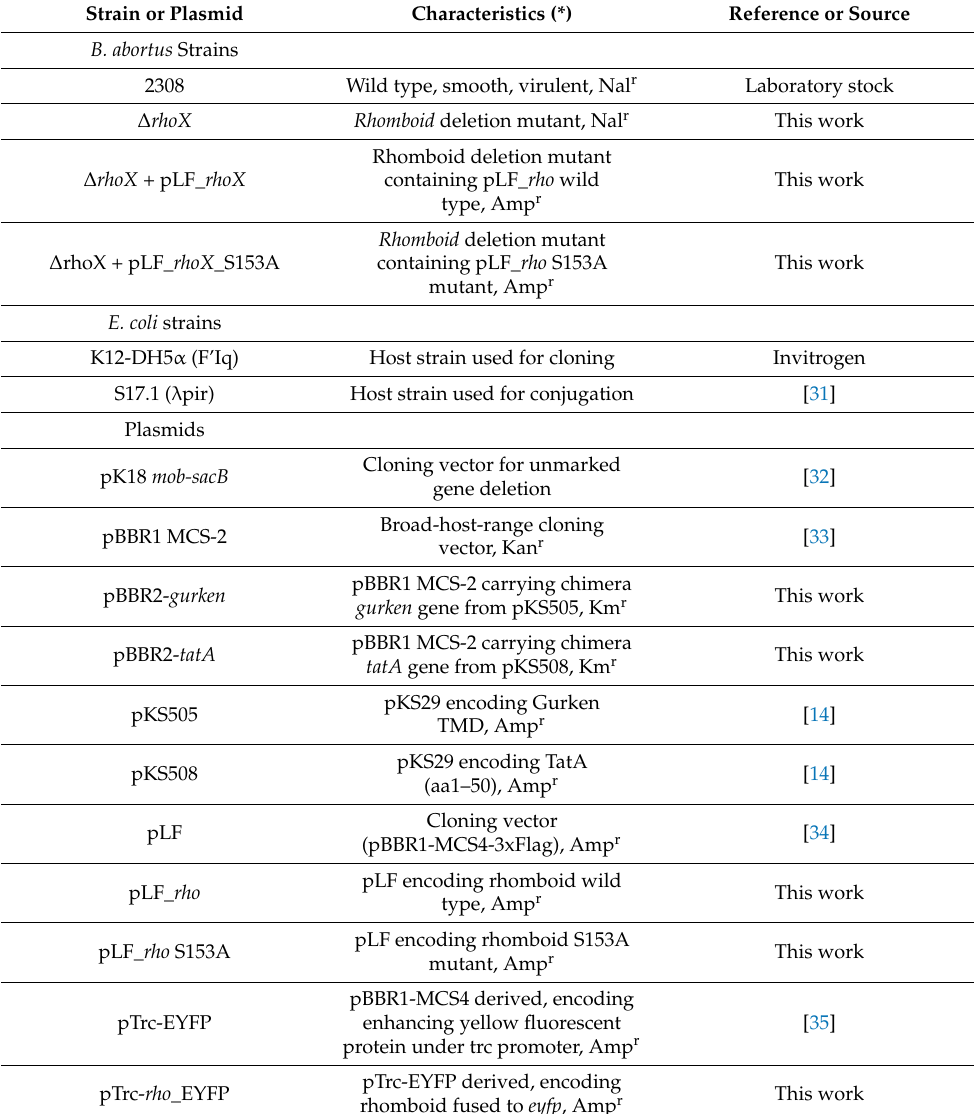
Table 1. Plasmids and bacterial strains used in this